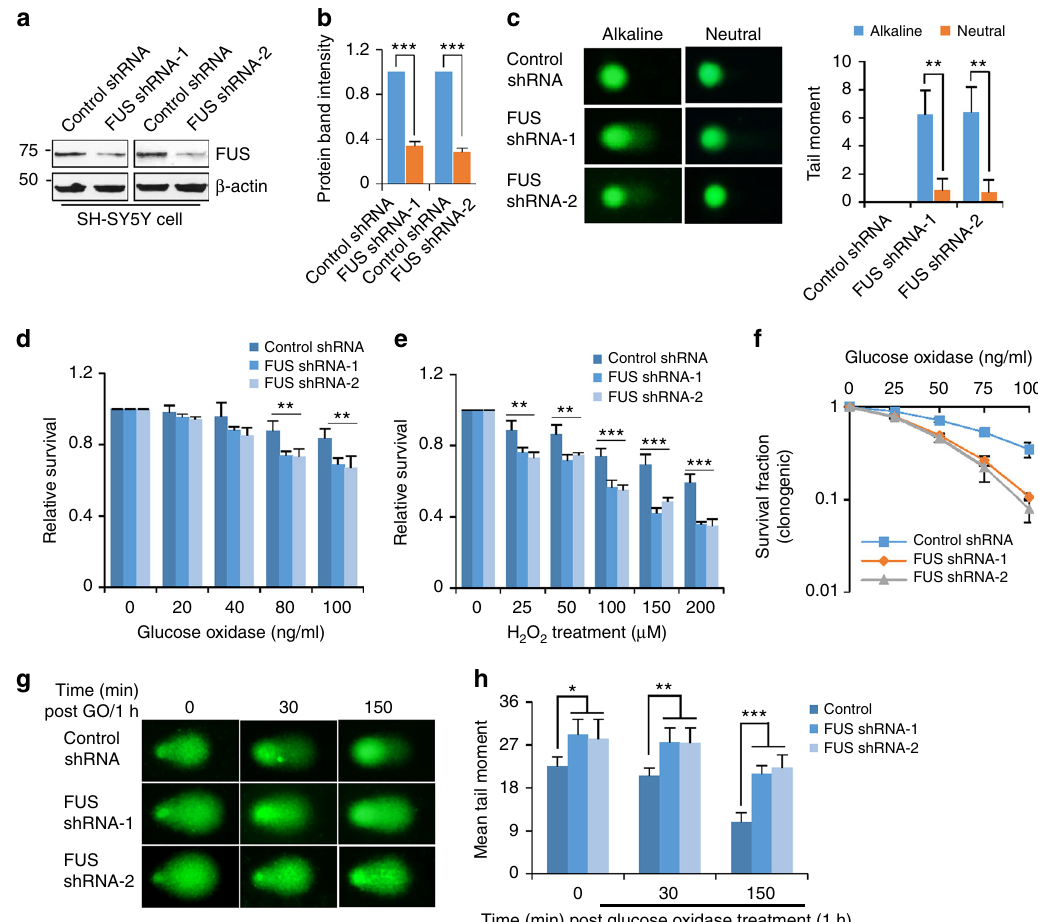
Fig. 1 Loss of FUS induces SSB accumulation and ROS sensitization. a , b Immunoblot (IB) showing FUS knockdown (KD) by shRNAs. Total lysate were extracted from SH-SY5Y cells 48 h after the transfection with two individual FUS shRNAs. β -actin was probed as loading control. Quantitation of relative band intensity of FUS shRNA vs Control shRNA shown in b . The error bars are standard deviation of experiments performed in triplicate (*** p < 0.001, two- tailed unpaired Student ’ s t -test). c Alkaline and neutral comet assay of control vs FUS KD SH-SY5Y cells. The quantitation of mean tail moment from 50 randomly selected nuclei is shown in the histogram. The error bars are standard deviation. (** p < 0.01, two-tailed unpaired Student ’ s t -test). d , e MTT- based viability analysis of FUS KD SH-SY5Y cells, treated with increasing doses of GO or H 2 O 2 . The cells were incubated with GO for 1 h or H 2 O 2 as indicated dose for 3 h, 48 h after the FUS shRNA transfection. MTT assay was performed 24 h after the treatment. The error bars are standard deviation